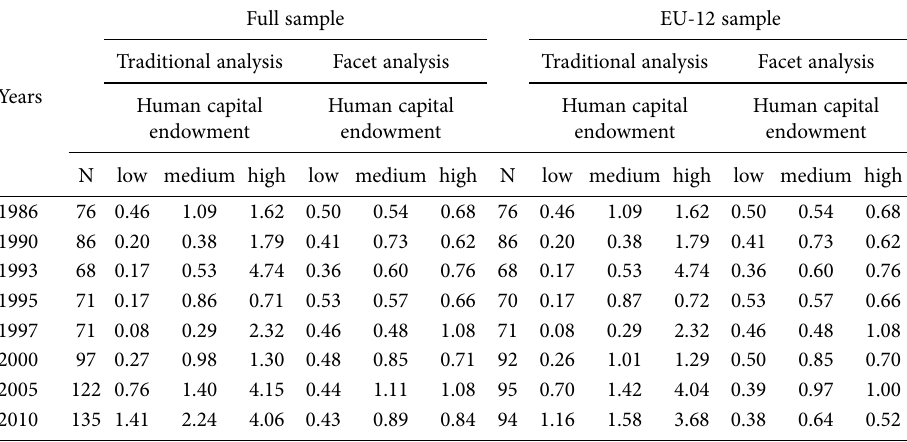
Table 5. Marginal rates of substitution between paid labour and family labour by human capital catego-